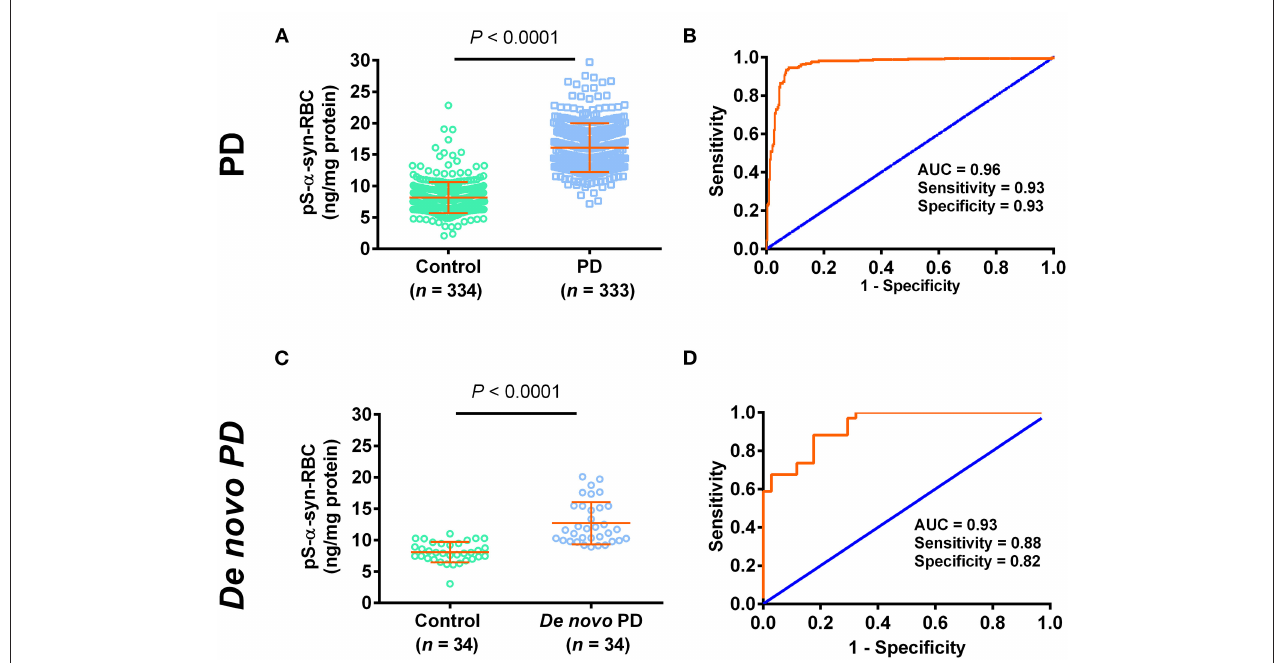
FIGURE 1 | Performance of pS- α -syn-RBC in diagnosing Parkinson’s disease. (A,C) Concentrations of pS- α -syn-RBC in Parkinson’s disease (PD) vs. controls in the PD (PD: 333, control: 334) and de novo (PD: 34, control: 34) study. (B,D) Receiver operating characteristic (ROC) curves for the diagnosis of PD in the PD and de novo PD